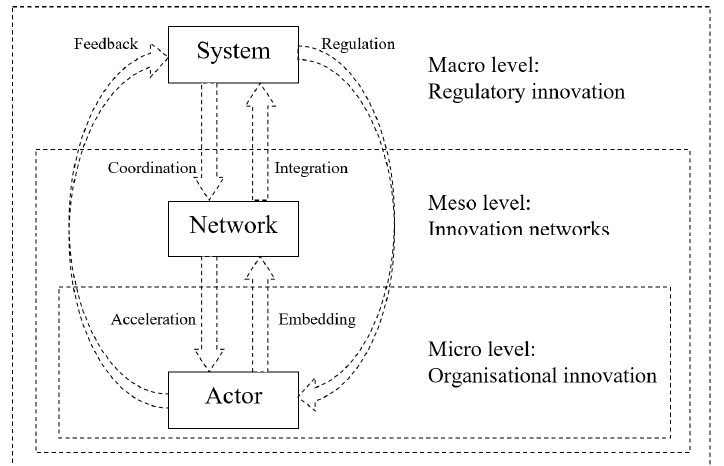
Figure 2. A three-level synergistic evolutionary analysis framework for the EAIS: actors, networks, and institutions.